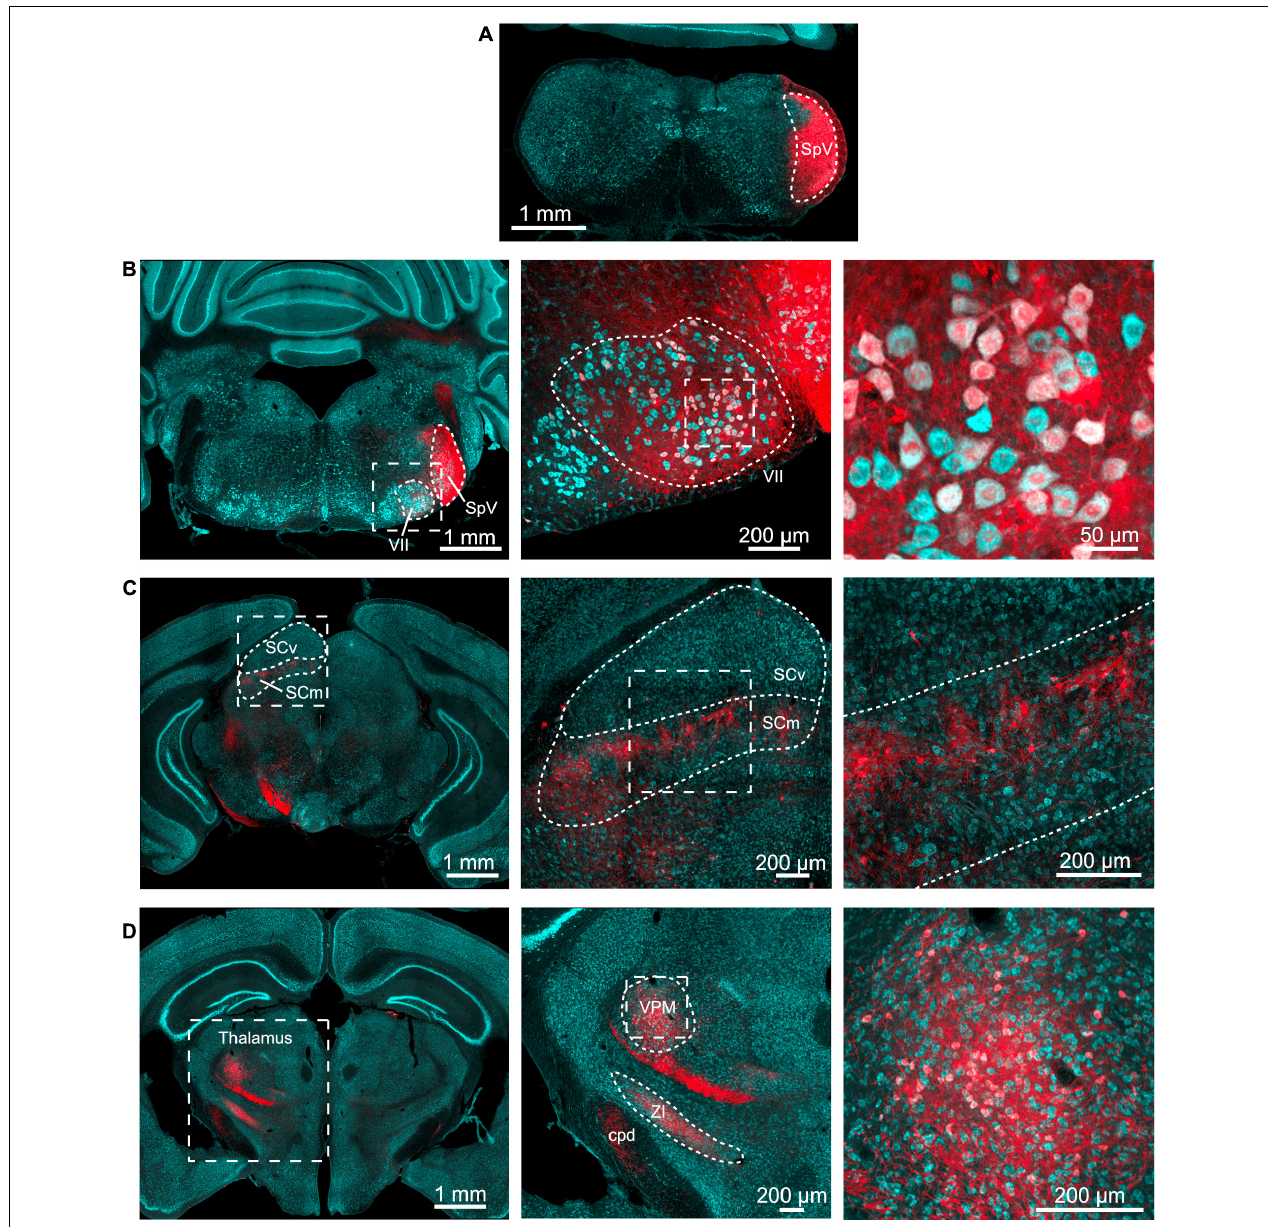
FIGURE 1 | Spinal trigeminal nucleus injection labels expected targets. (A) AAV1-Syn-Cre (200 nl) was injected into the SpV of tdTomato-reporter (Ai9) mice. This is the injection site. Cyan – Nissl and red – tdTomato. (B) Neurons in the ipsilateral facial motor nucleus (VII) were labeled. Outline of SpV shown includes the tracts to its lateral side. Middle, right, magnified view of facial motor nucleus. (C) Neurons in the motor-related areas of the contralateral superior colliculus were labeled. SCv, superior colliculus, visual layers; SCm, superior colliculus, multisensory layers. Middle, right, magnified views of the boxed regions in panel to left. (D) Neurons in the thalamus were labeled. Middle, right, magnified views of the boxed regions in panel to left. ZI, zona incerta; VPM, ventral posteromedial nucleus of the thalamus; cpd, cerebellar peduncle. All images are from the same animal, although similar results were obtained from four animals with injection volumes varying from 100 to 500